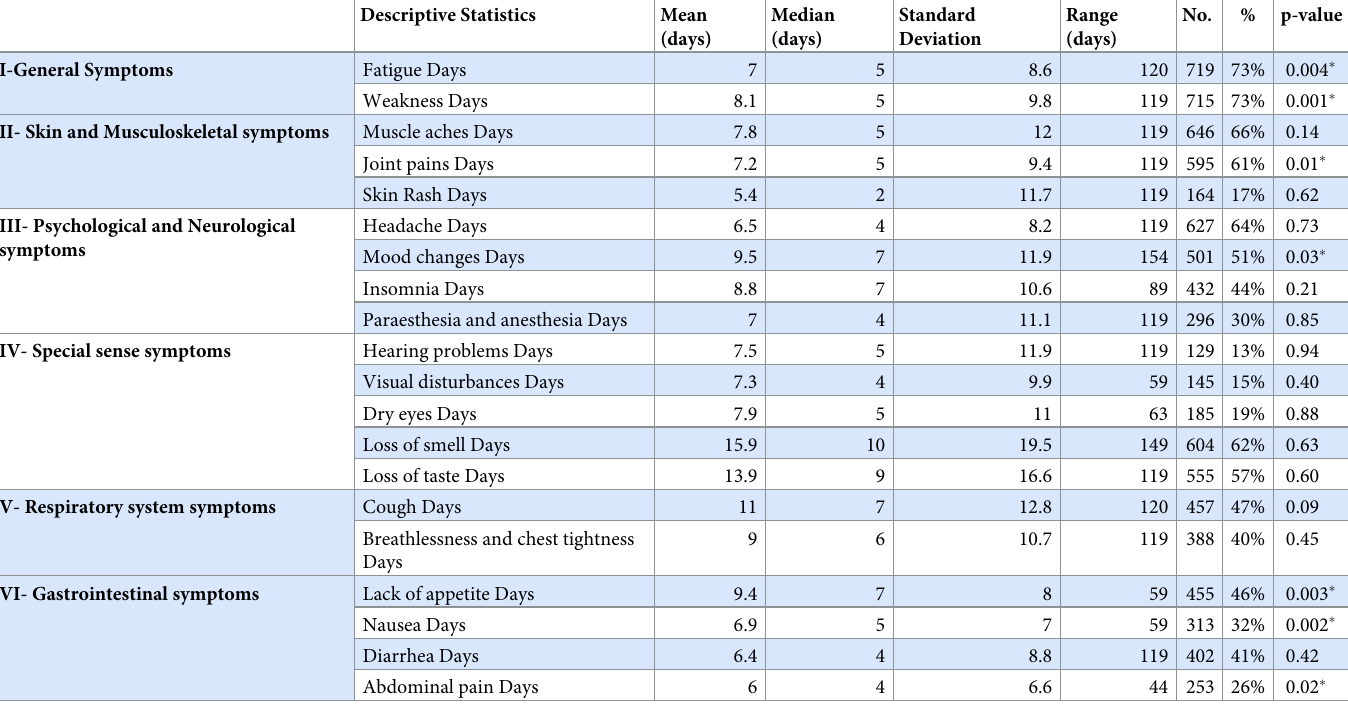
Table 2. Persistence days of post-recovery of COVD-19 recorded symptoms in 979 studied subjects. Descriptive